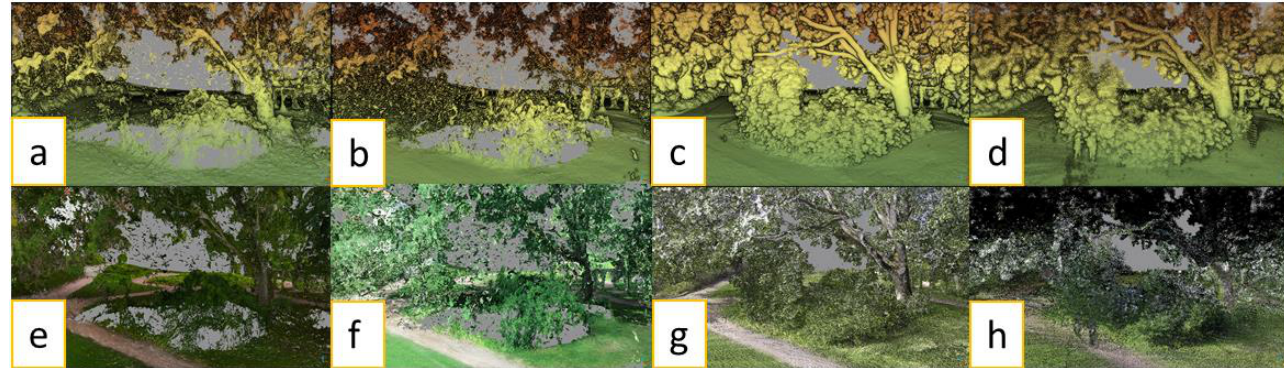
Figure 8. Comparisons of point clouds for very small trees. In the top row, the point clouds are colored with the height ramp and in the bottom row with RGB colorization.